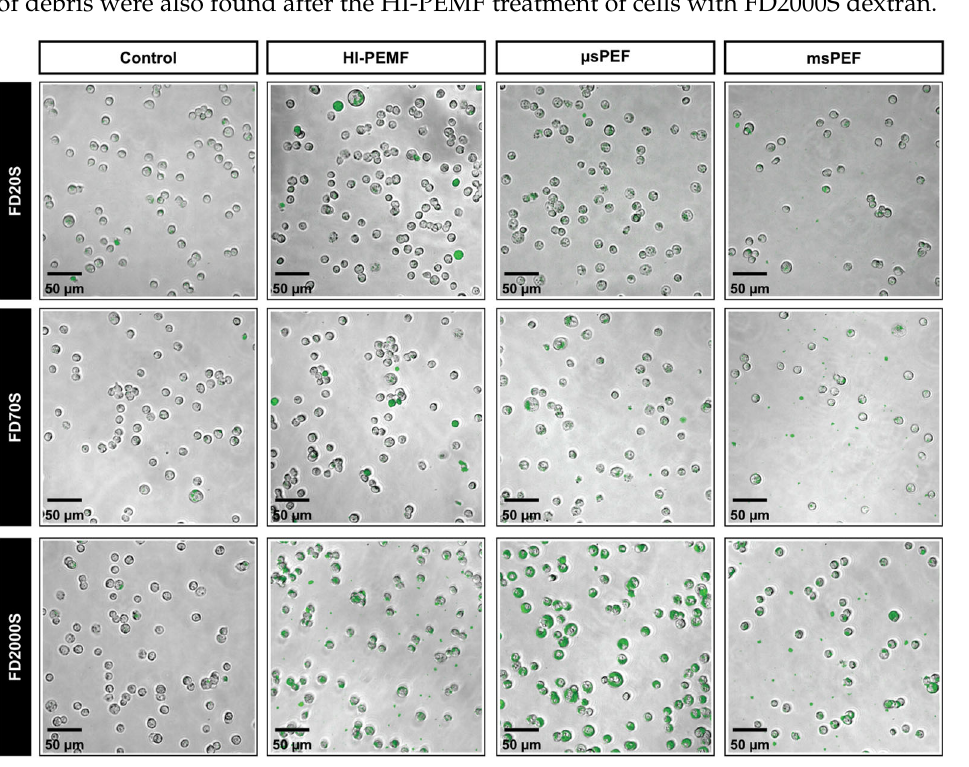
Figure 6. Microscopic images of fluorescently labelled cells with dextrans after application of HI ‐ PEMF, µ sPEF and msPEF presented as an overlay of brightfield and fluorescence channel. Each column shows from left to right: control, HI ‐ PEMF, μ sPEF and msPEF samples. Each row shows FD20S, FD70S and FD2000S from top to bottom.